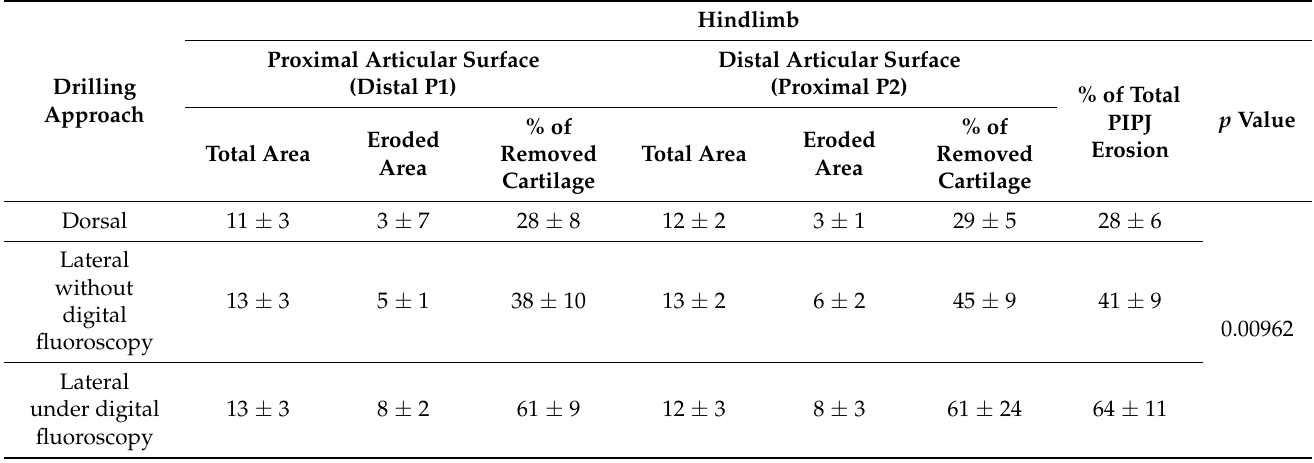
Table 2. Mean ± SD total area (cm 2 ), eroded area (cm 2 ) and percentage of removed cartilage in proximal and distal articular surfaces of the proximal interphalangeal joint (PIPJ) in the hindlimb. Comparison of the three techniques.